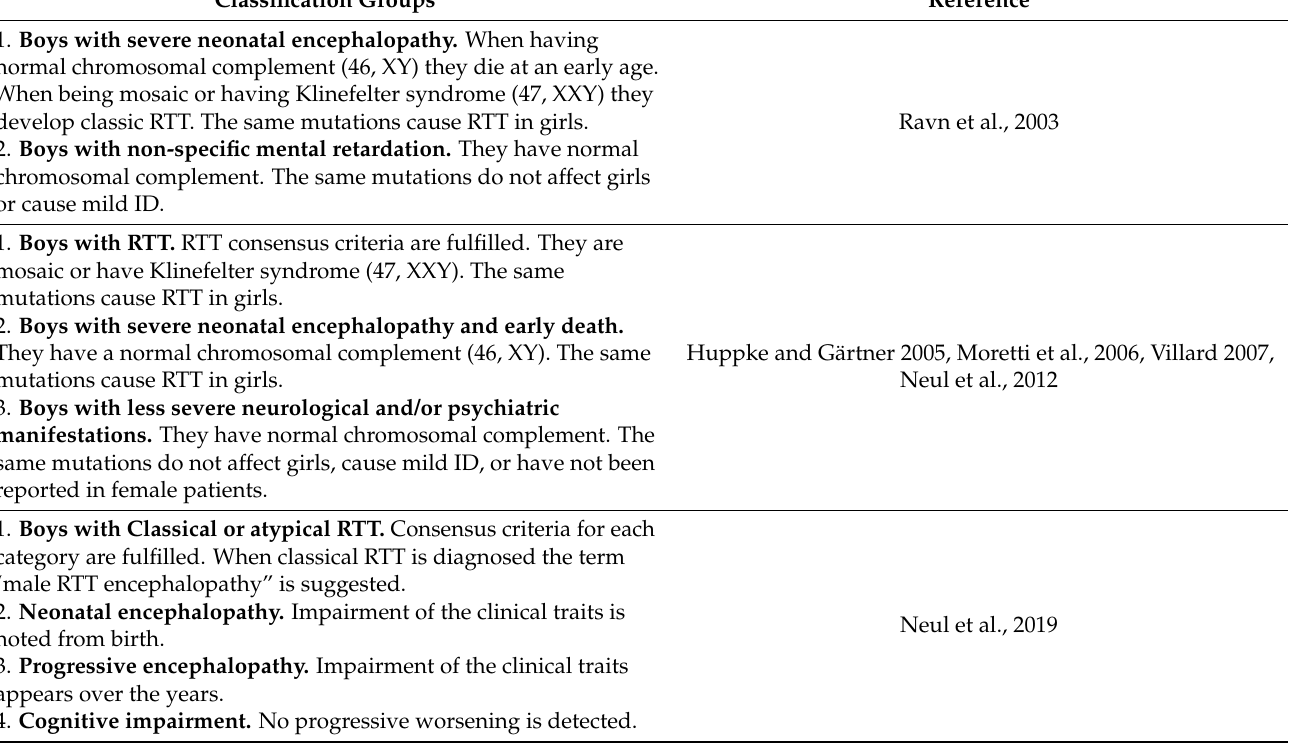
Table 1. Different methods of classifying male cases with mutations in MECP2 depending on clinical and/or genetic criteria. Classification